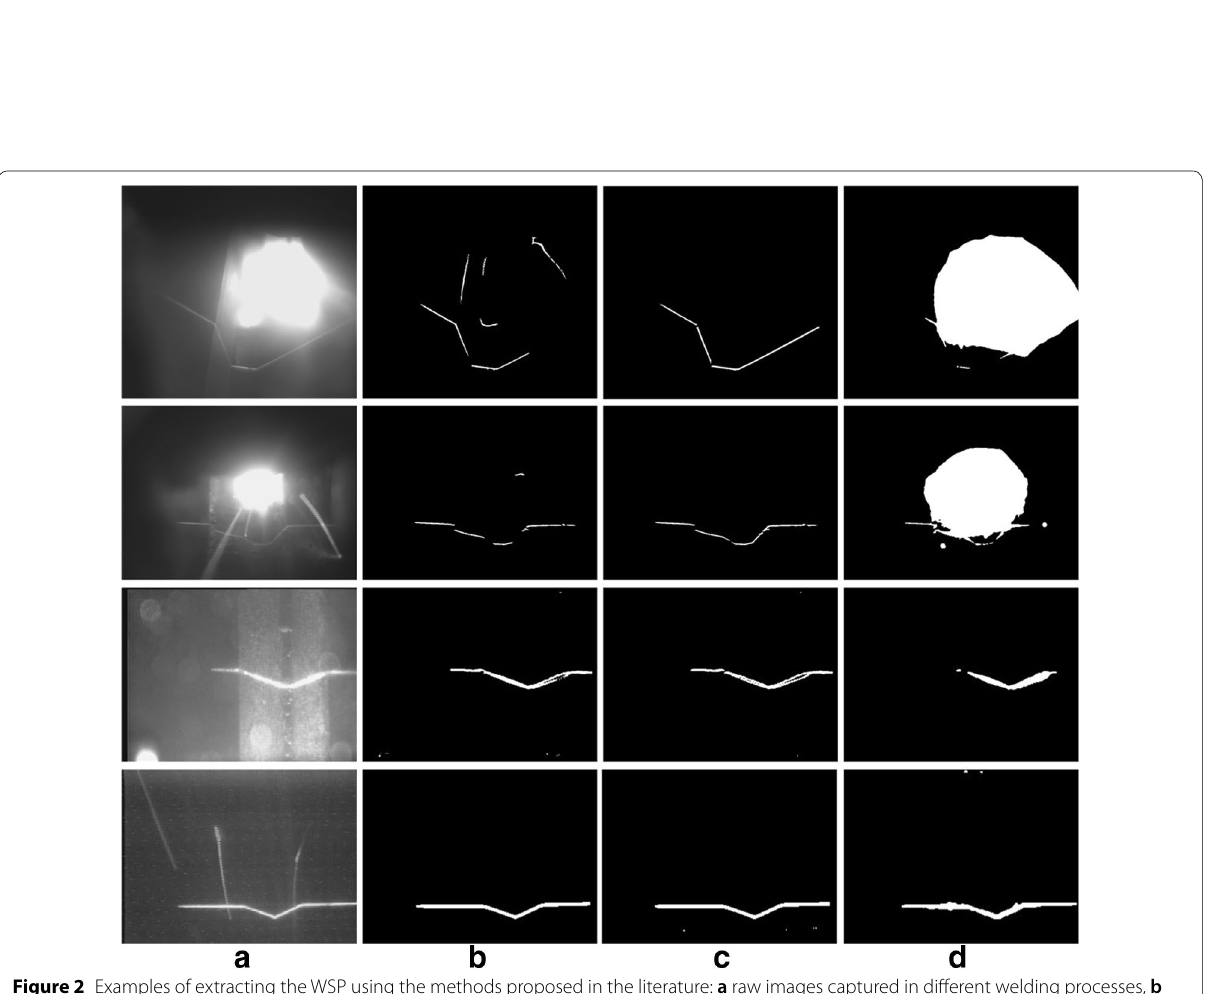
Figure 2 Examples of extracting the WSP using the methods proposed in the literature: a raw images captured in different welding processes, b results using the method proposed in Ref. [21], c results using the method proposed in Ref. [22], and d in Ref.